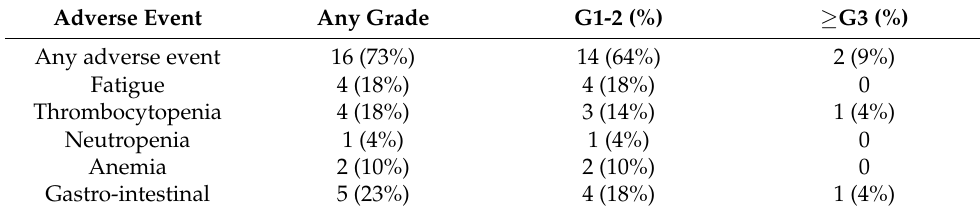
Table 5. Treatment-related adverse